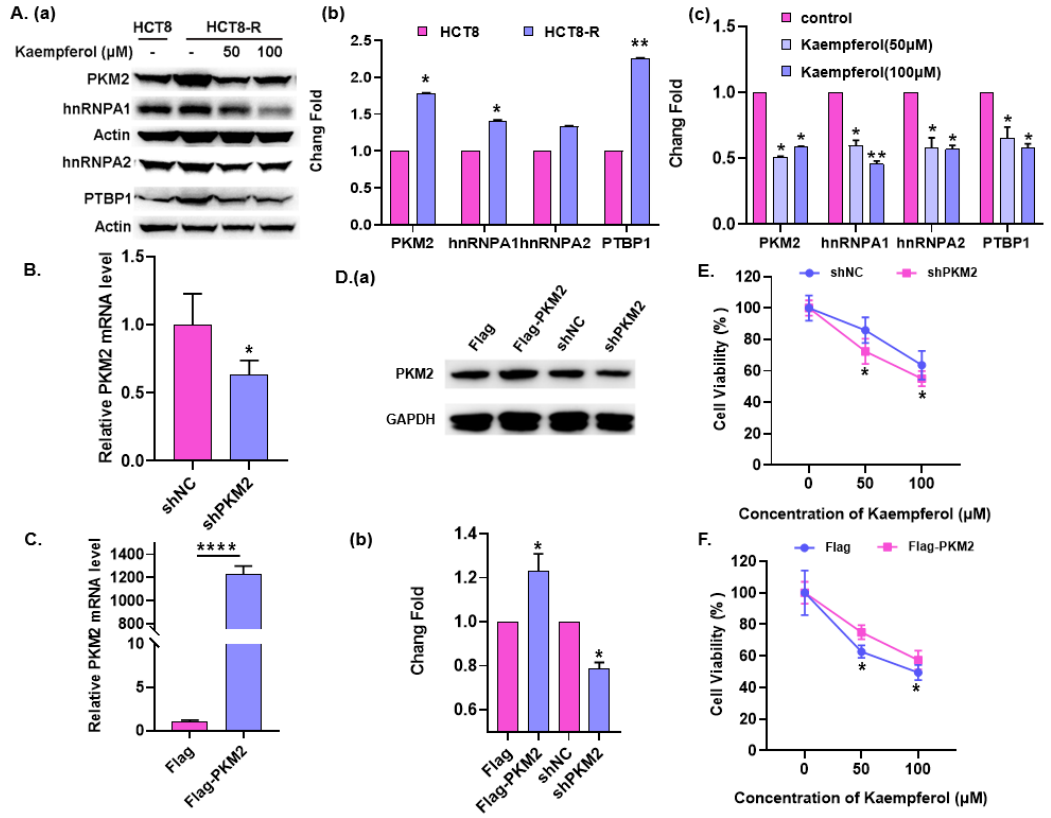
Figure 4. PKM2 mediates kaempferol, increasing the HCT8-R’s sensitivity to 5-Fu. ( A ) The protein expression of PKM2 (pyruvate kinase M2 isoform) and hnRNPA1/A2 (heterogeneous nuclear ribonucleoprotein A1/A2)/PTBP1 (polypyrimidine-tract-binding protein) in HCT8 and HCT8-R cells was analyzed by Western blot. ( a ) A representative result from three independent experiments is shown. ( b and c ) The densitometry analysis of relative protein expression is shown in a histogram. ( B and C ) qPCR was used to analyze the expression of PKM2 mRNA in HCT8-R cells after knockdown (B) and over-expression (C) of PKM2. ( D ) Western blot was used to analyze the expression of PKM2 protein in HCT8-R cells after overexpression or knockdown of PKM2. ( a ) A representative result from three independent experiments is shown. ( b ) The densitometry analysis of relative protein expression is shown in a histogram. ( E ) After transfecting with shNC or shPKM2, the HCT8-R cells were cultured in medium containing kaempferol for 48 h, and a CCK-8 assay was used to detect cell survival. ( F ) After transfecting with Flag or Flag-PKM2, the HCT8-R cells were cultured in medium containing kaempferol for 48 h, and a CCK-8 assay was used to detect cell survival. Data represent means ± SD from three independent experiments. * p < 0.05, ** p < 0.01, **** p < 0.0001.